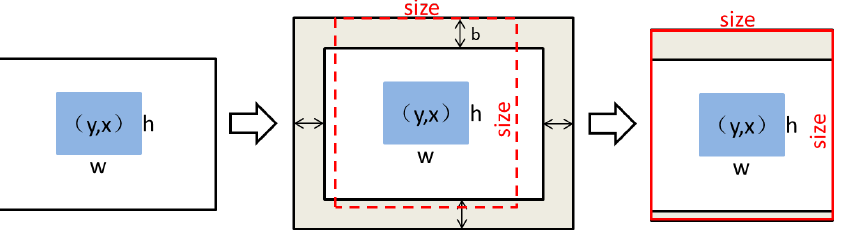
Figure 5. Process diagram of image cropping. The results in the graph are cut from the original image according to the size of the target annotation box; specifically, a certain size of boundary filling is added on the basis of the original target annotation box, then the required fixed-size image pairs are generated by